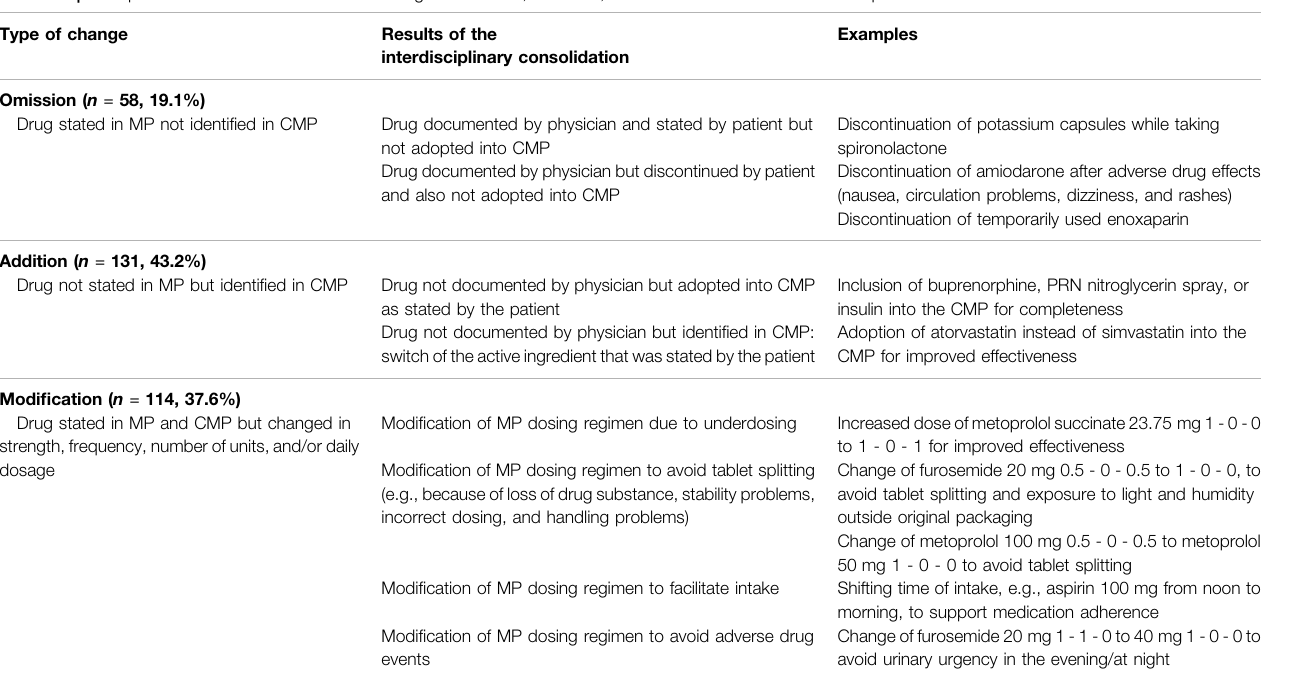
TABLE 2 | Examples of the medication reviews resulting in omissions, additions, or modi fi cations of the medication plan. Type of